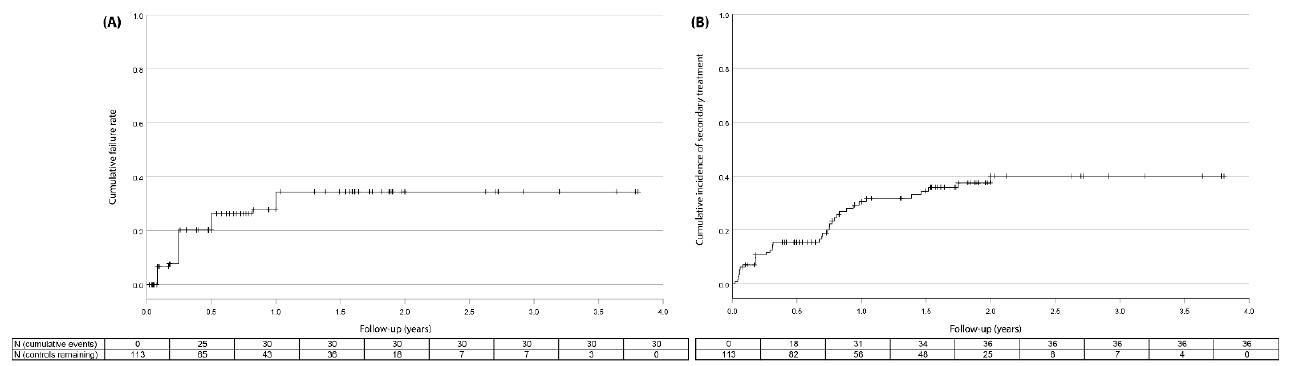
Figure 2. Scatterplot showing the pre- and postoperative IOP of primary (circles) and secondary (crosses) MP-TSCPC treatments. The dotted line represents an IOP reduction of 20%.